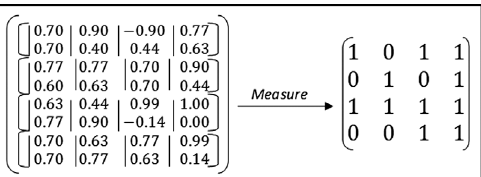
Figure 6. Measure of Quantum